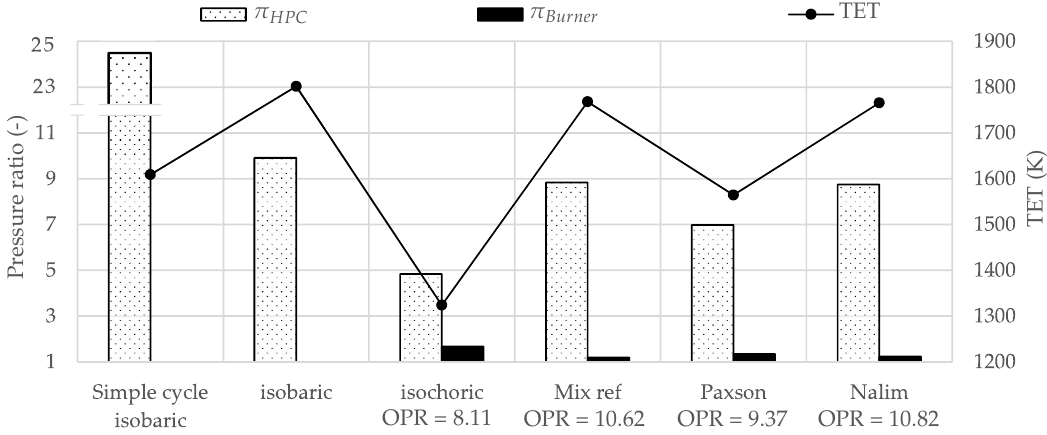
Figure 12. Pressure ratio and TET for recuperated